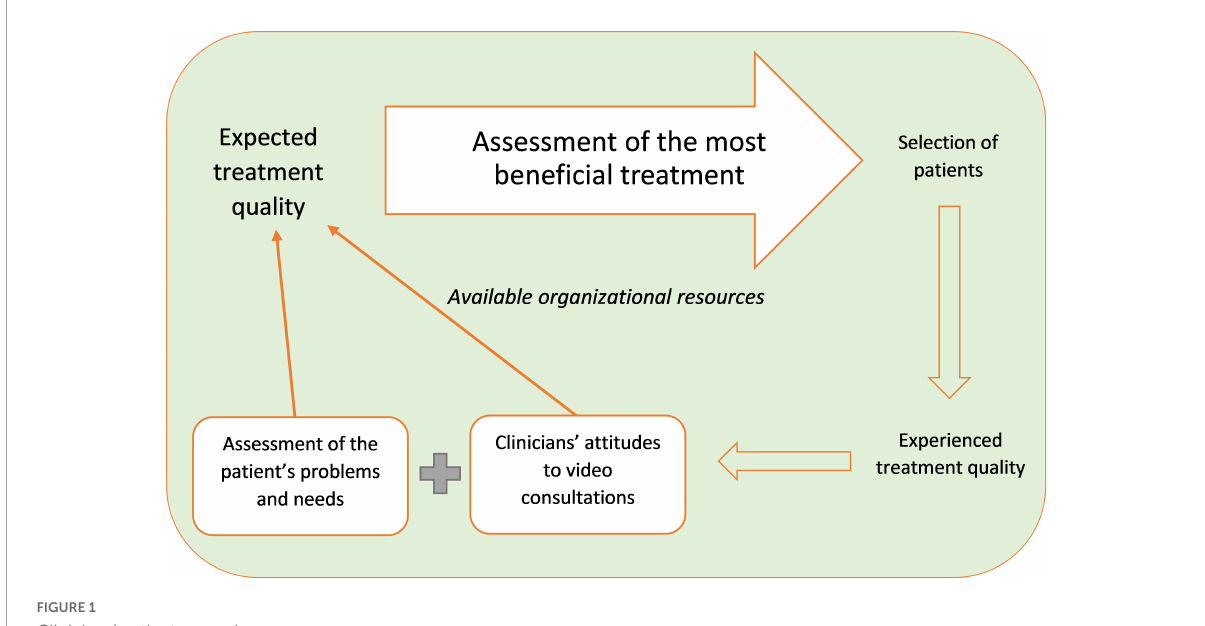
FIGURE1 Clinicians’ patient screening